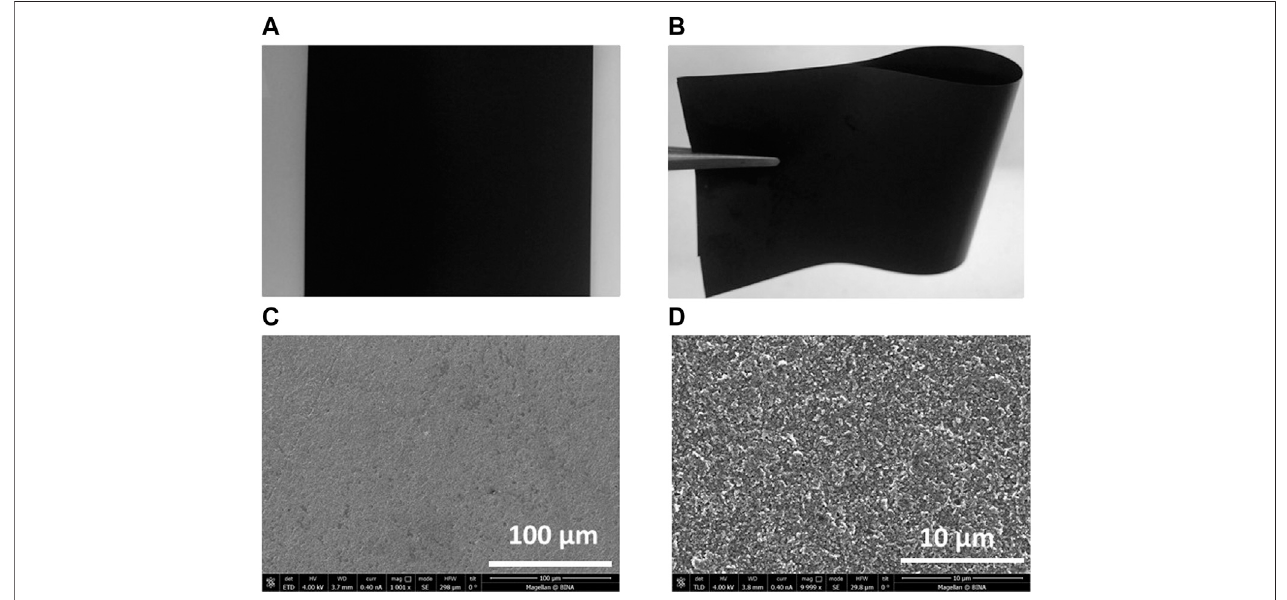
FIGURE 1 | Photographic images of the polymeric web (A) fl at and (B) bent polymeric web and HRSEM images at ranges of (C) 100 µm at 1 k magni fi cation and (D) 10 µm at 10 k magni fi cation.